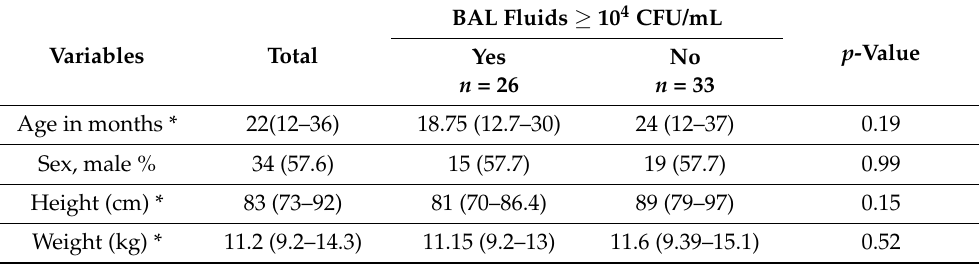
Table 1. Patients’ characteristics ( n = 59).